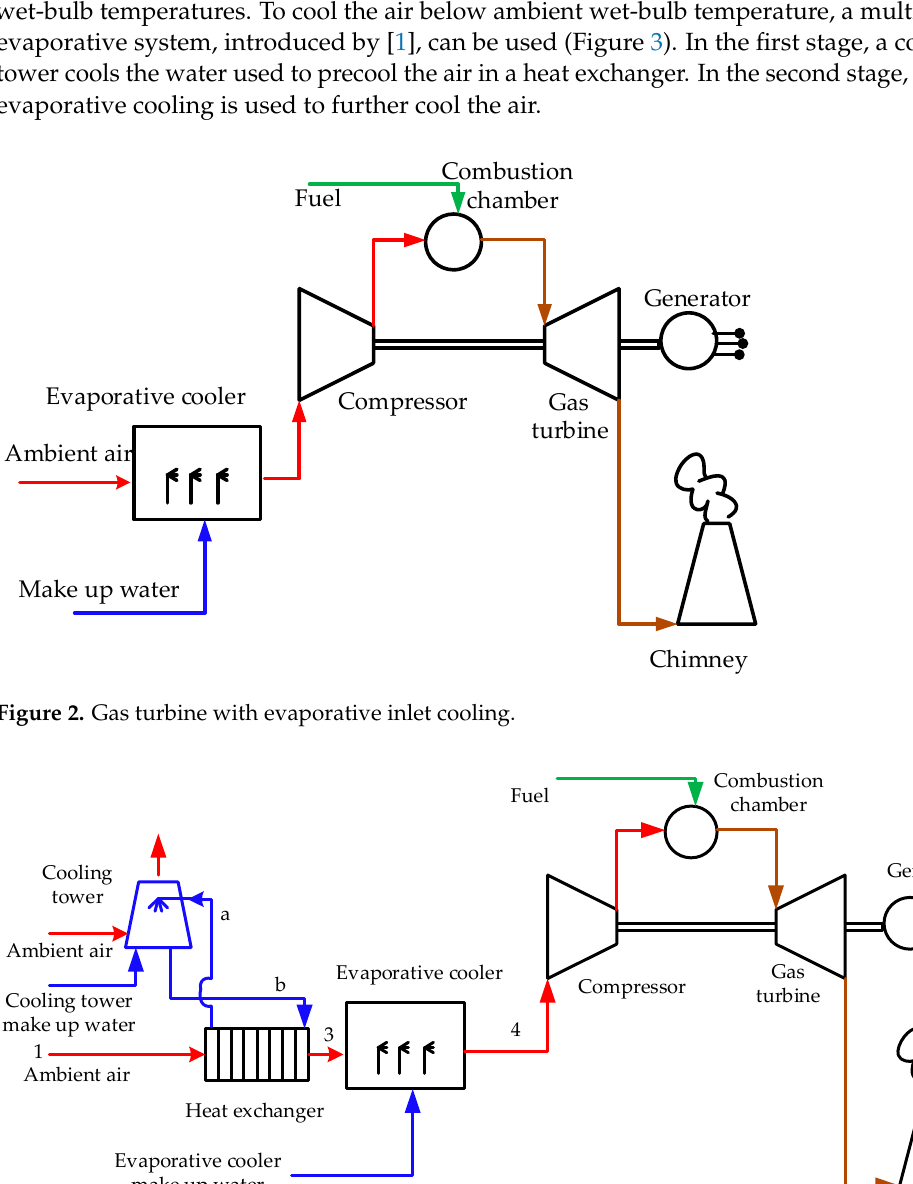
Figure 3. Gas turbine with two-stage evaporative inlet cooling.